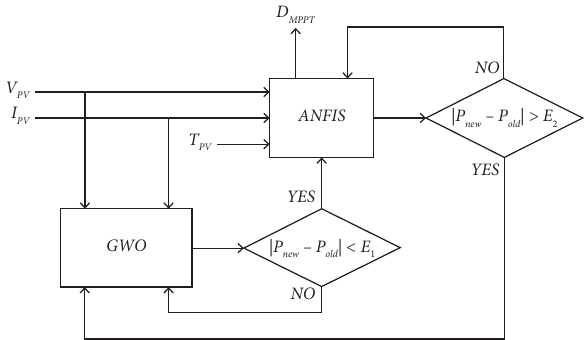
Figure 6: PV energy system with hybrid GWO-ANFIS based